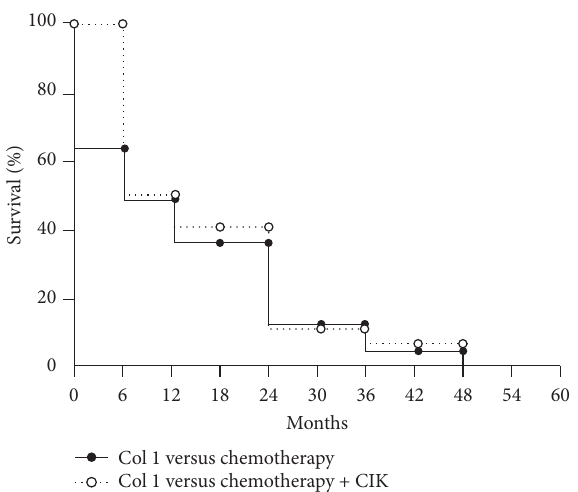
Figure 1: Cumulative survival rate of the patients analyzed by the Kaplan-Meier method. No patient was alive after five years (modified from